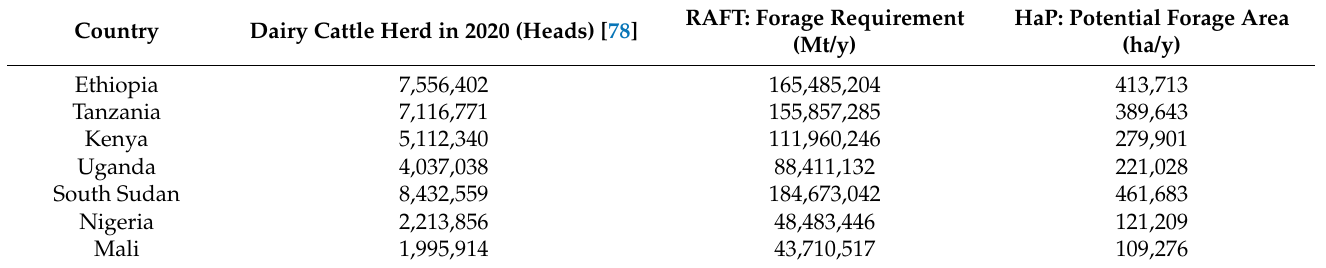
Table 4. Annual forage requirement by the dairy cattle herd and potential annual area for forages.